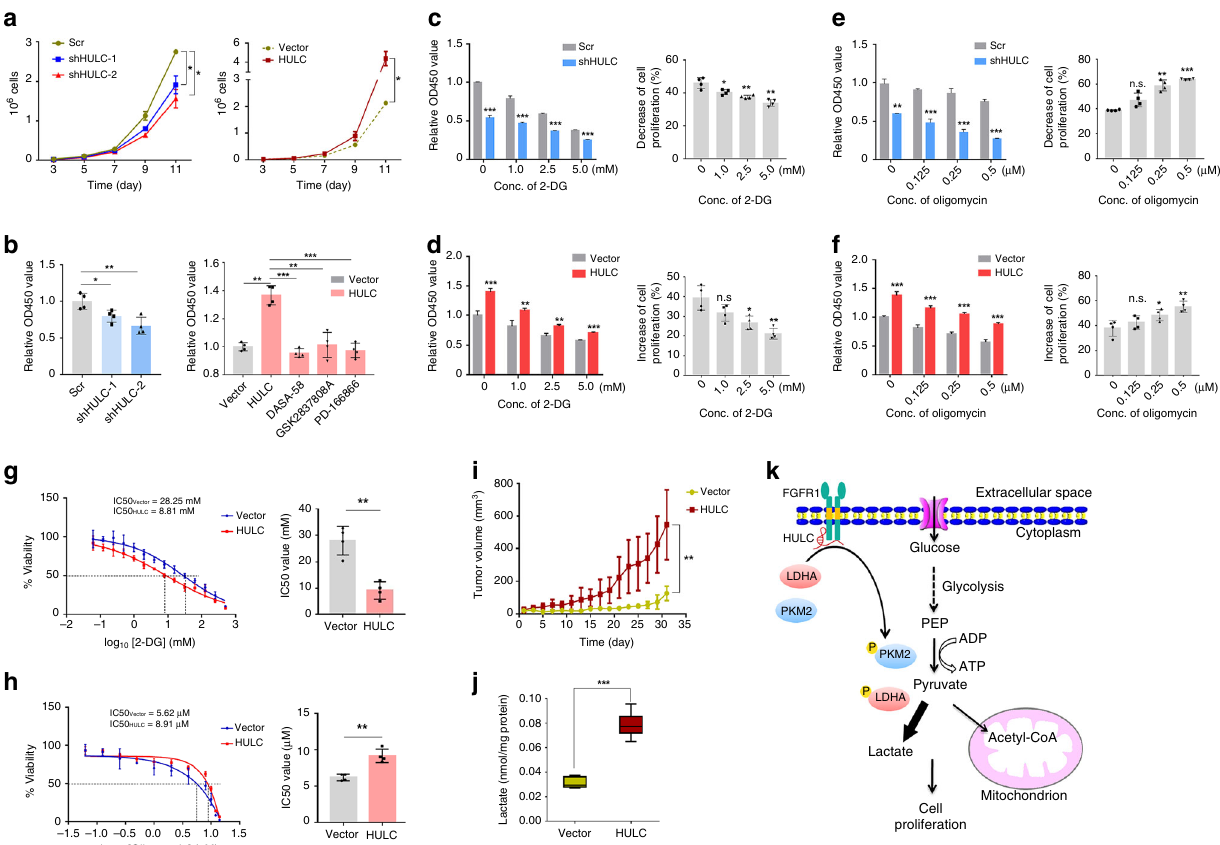
Fig. 7 HULC promotes cell proliferation by elevating aerobic glycolysis. a The growth curve of HepG2 cells with HULC knockdown (left panel) or overexpression (right panel). Statistical analysis was performed by one-way analysis of variance (ANOVA) (* P < 0.05). b Proliferation of HepG2 cells with HULC knockdown (left panel) or overexpression (right panel) was measured with a CCK8 assay. For rescue experiments, HepG2-HULC cells were treated by FGFR1 inhibitor PD 166866 (2.5 μ M), PKM2 activator DASA-58 (30 μ M), or LDHA inhibitor GSK2837808A (10 μ M), respectively. DMSO was added instead in the control groups. HepG2 cells with HULC knockdown ( c ) or overexpression ( d ) were incubated with indicated concentrations of 2-DG, and cell proliferation was measured with the CCK8 assay. HepG2 cells with HULC knockdown ( e ) or overexpression ( f ) were incubated with indicated concentrations of oligomycin, and cell proliferation was measured with the CCK8 assay. IC50 values of 2-DG ( g ) and oligomycin ( h ) in HepG2-HULC cells were calculated by dose curve analysis. In b – h , statistical analysis was performed by two-sided Student ’ s t test. Bars, mean; error bars, s.d. ( n = 4 independent experiments, * P < 0.05, ** P < 0.01, *** P < 0.001, n.s., not signi fi cant). i HepG2 cells expressing empty vector or HULC were injected subcutaneously into nude mice, and tumor volumes were measured every 2 days ( n = 4 for each group). Bars, mean; error bars, s.d. (*** P < 0.001, by one- way ANOVA). j The levels of lactate in the tumors were measured and normalized using protein concentrations ( n = 13 tissues). The box plot includes data between the 25th and 75th percentiles, with the horizontal line representing the median. The upper whisker is the maxima, and the lower whisker is the minima. Bars, mean; error bars, s.d. (*** P < 0.001, by two-sided Student ’ s t test). k The proposed molecular mechanism by which HULC regulates cell proliferation through modulating glycolysis. See also Supplementary Fig. 7. Source data are provided as a Source data fi cancer-speci fi c lncRNA prostate cancer gene expression marker 1